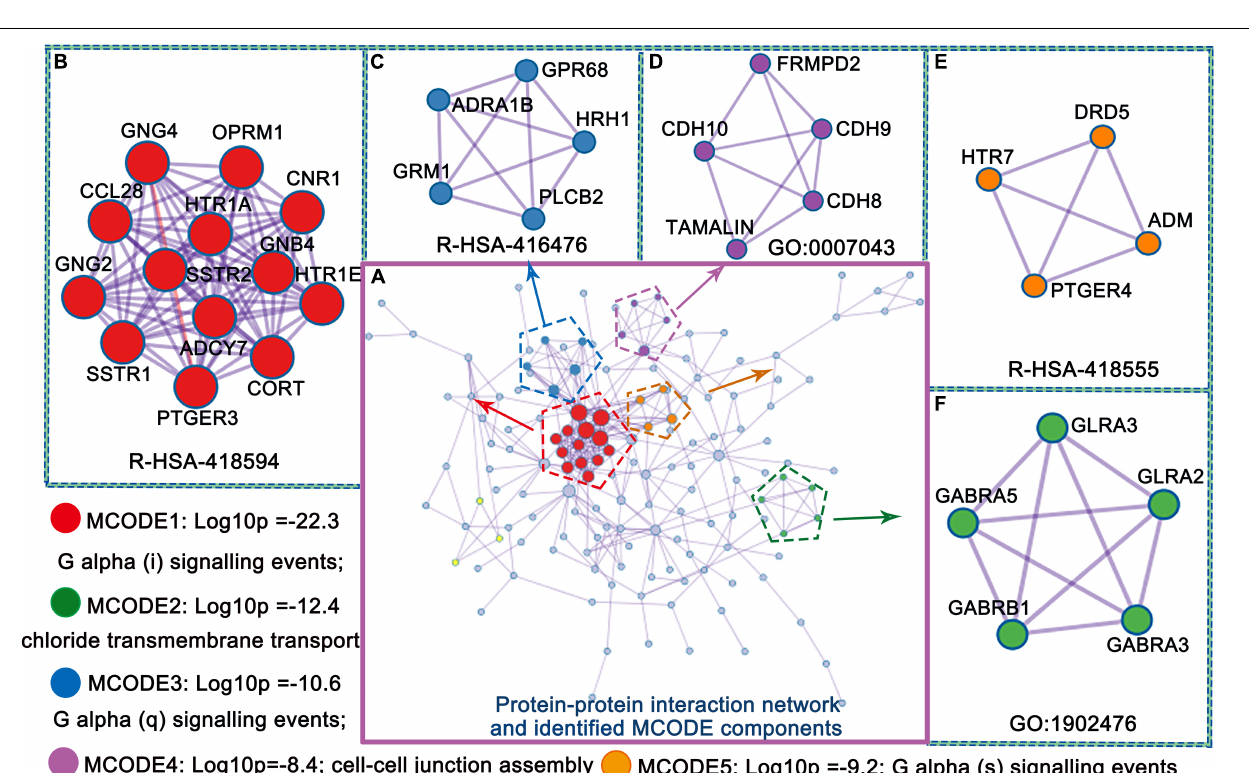
Frontiers in Aging Neuroscience |